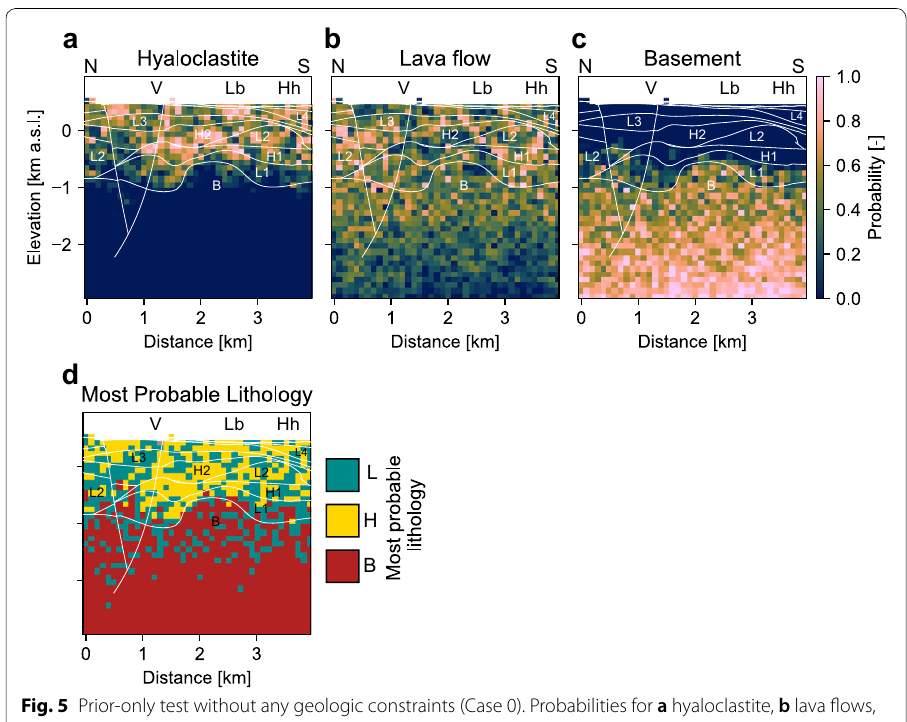
Fig. 5 Prior-only test without any geologic constraints (Case 0). Probabilities for a hyaloclastite, b lava flows, and c basement intrusions. d Most probable lithologic model. Results are plotted along Section 1 (N–S). Boundaries of the stratigraphic units and faults shown with white lines. Letters indicate proximity to different sub-areas of the Krafla field ( V Vitismor, Lb Leirbotnar, Hh